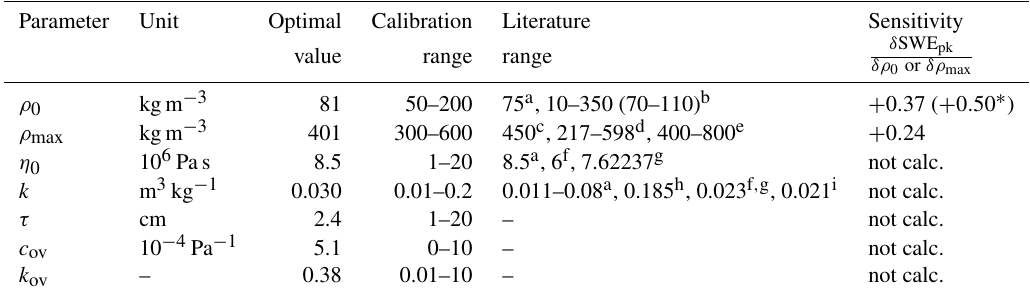
Table 3. The seven parameters of (cid:49) SNOW . The last column depicts model sensitivity to changes in the density parameters. The respective gradients [kgm − 2 per kgm − 3 ] are means over the whole calibration